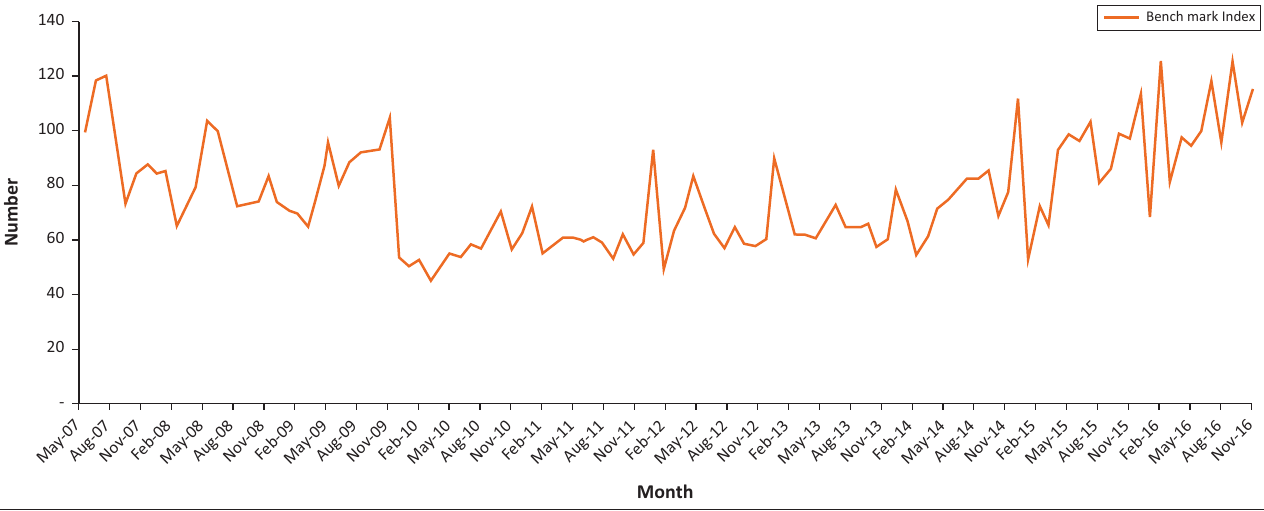
FIGURE 7: Consolidated benchmark